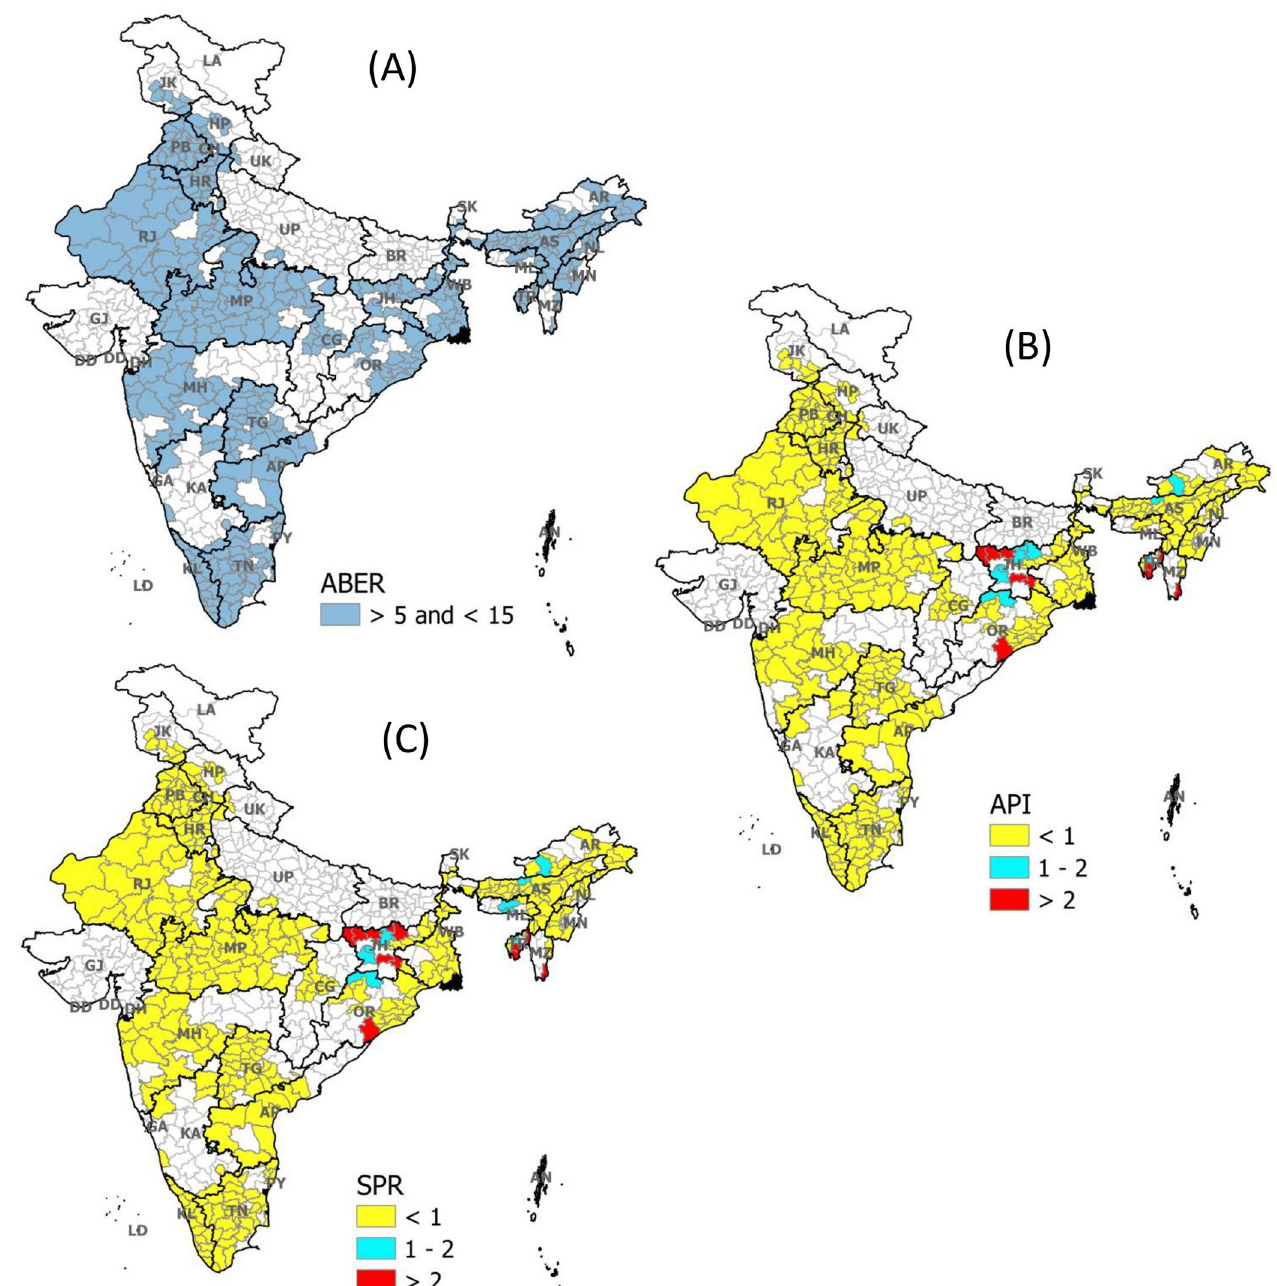
Fig 3. Distribution of API and SPR among moderate surveillance districts of India. (A): Representing all districts (blue shaded) of India where ABER ranges from 5 to 15 (Strata 2) (B): Distribution of API as per NSP in these districts (Strata 2) (C): Distribution of SPR as per NSP in these districts (Strata 2)). ABER: Median Annual Blood Examination Rate across three years (2017–19); API: Median Annual Parasite Incidence across three years (2017–19); SPR: Median Slide Positivity Rate across three years (2017–19); NSP: National Strategic Plan 2017–22.